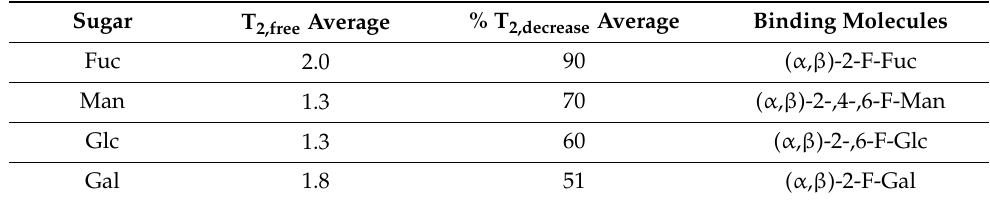
Table 1. Fluorinated monosaccharides that display e ff ective binding to DC-SIGN and observed averaged decrease in T 2 . These values are qualitatively related with the relative binding a ffi nity: Fuc moieties interact better, followed by Man [13]. The Gal moieties displayed a small change in the observed averaged decrease in T 2,free , highlighting that they are rather poor binders of DC-SIGN [13]. The average T 2,free was calculated for all the species depending on the particular sugar. The average T 2 decay % was computed for those species that exhibited a T 2 decay over